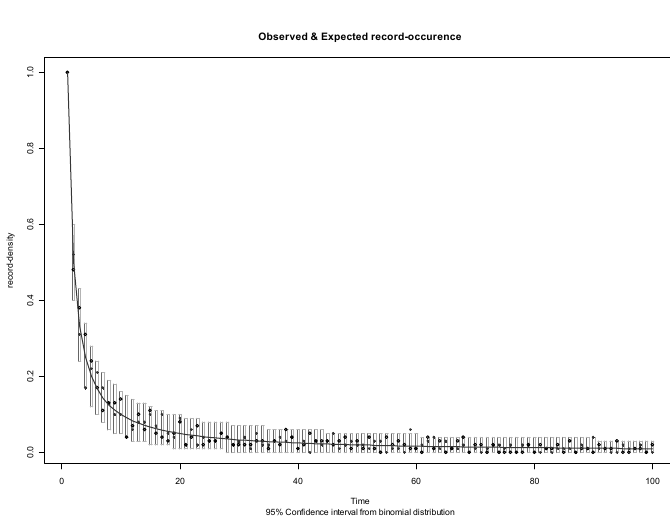
Figure 10 – Empirical estimates for the expectation value E n .